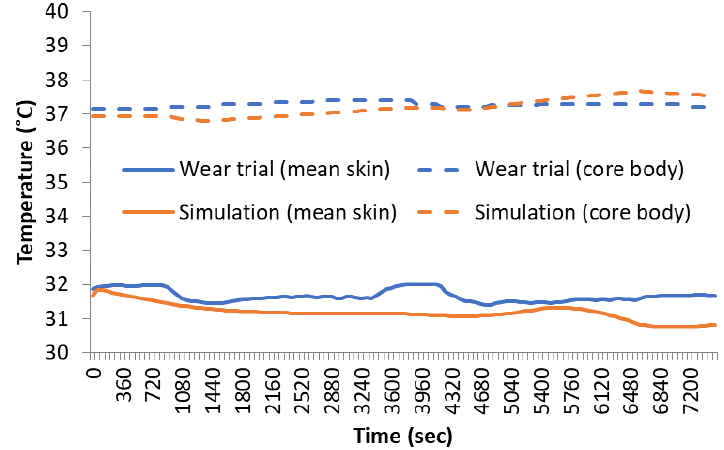
Figure 6. Mean skin and body core temperature during wear trial and simulation.